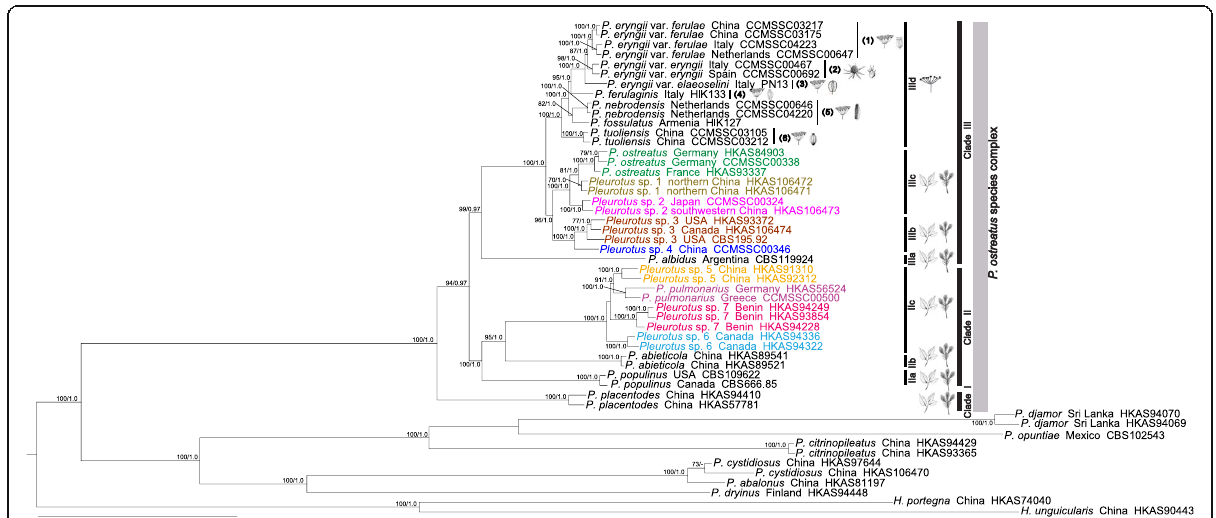
Fig. 1 Phylogenetic tree generated from a forty-locus dataset. The branch support values are indicated by the numbers above the branches (MLB ≥ 70%, BPP ≥ 0.95). The P. ostreatus species complex is marked on the right of the phylogenetic tree, three major clades and seven subclades are in the black frames. Every phylogenetic species in Clades IIc, IIIb and IIIc is marked with different colors. The line-drawings of substrate plants and seeds are from Flora of China and Google. Table 1 includes the details of reference collections for all